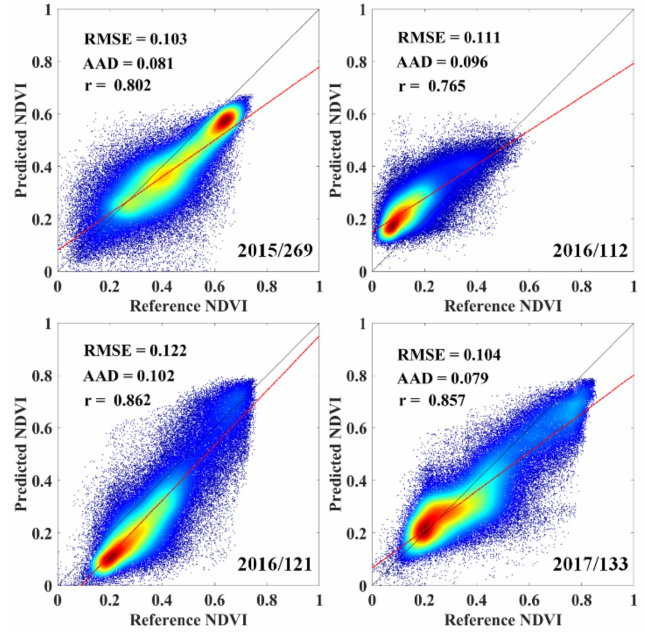
Figure 5. Scatter plots of predicted NDVI compared with GF-1 reference NDVI. The red line is the fitting line, and the black line is the 1:1 line. Negative pixels of the modelled NDVI corresponding to a body of water were not included in the statistical analysis.